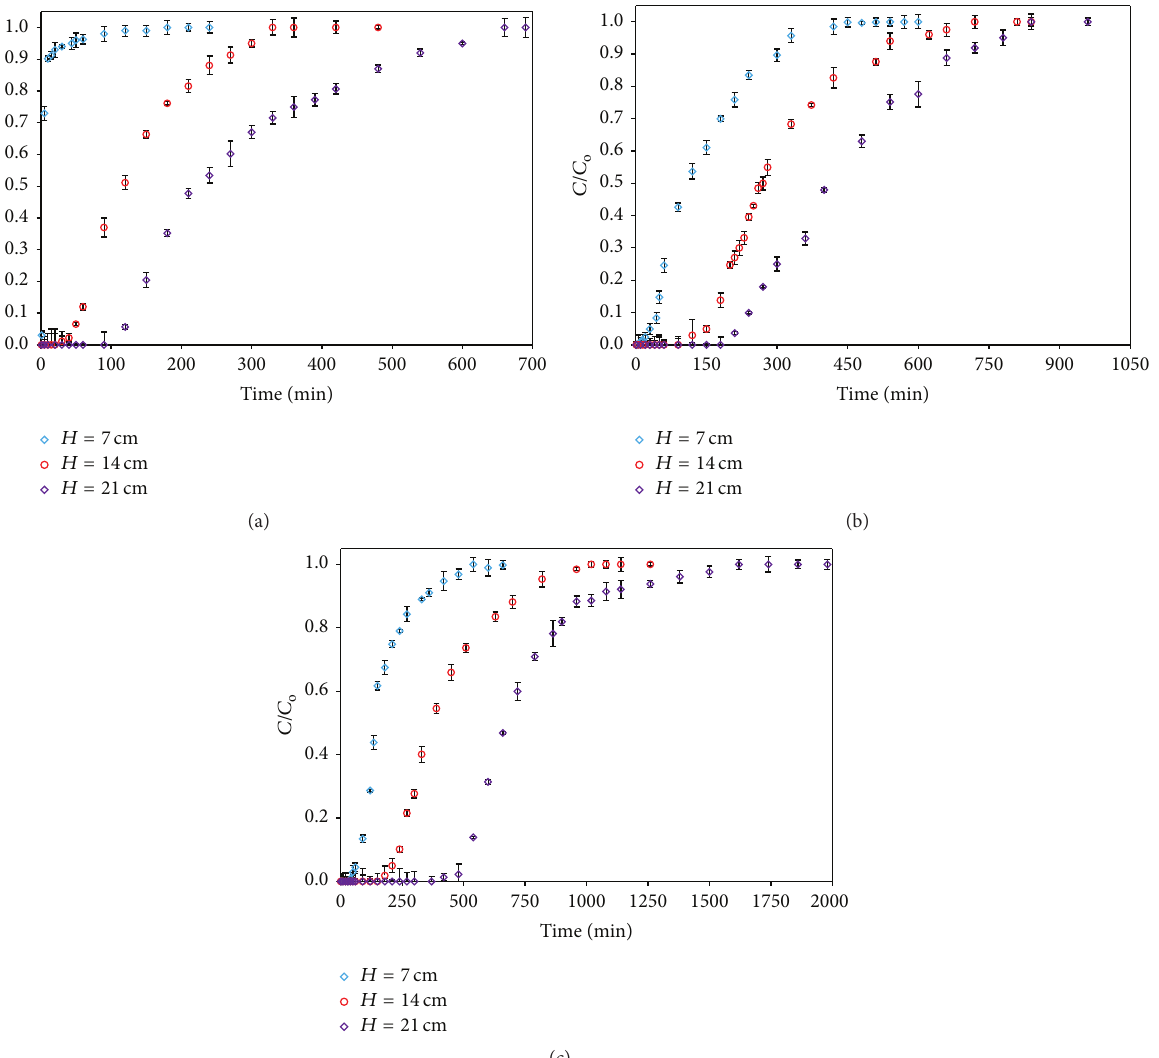
Figure 7: Effect of the bed height on the breakthrough curves of (a) Cd 2+ , (b) Cu 2+ , and (c) Pb 2+ . Experimental conditions: 0.1mM initial metal concentration, pH 4.5, and 25 ∘